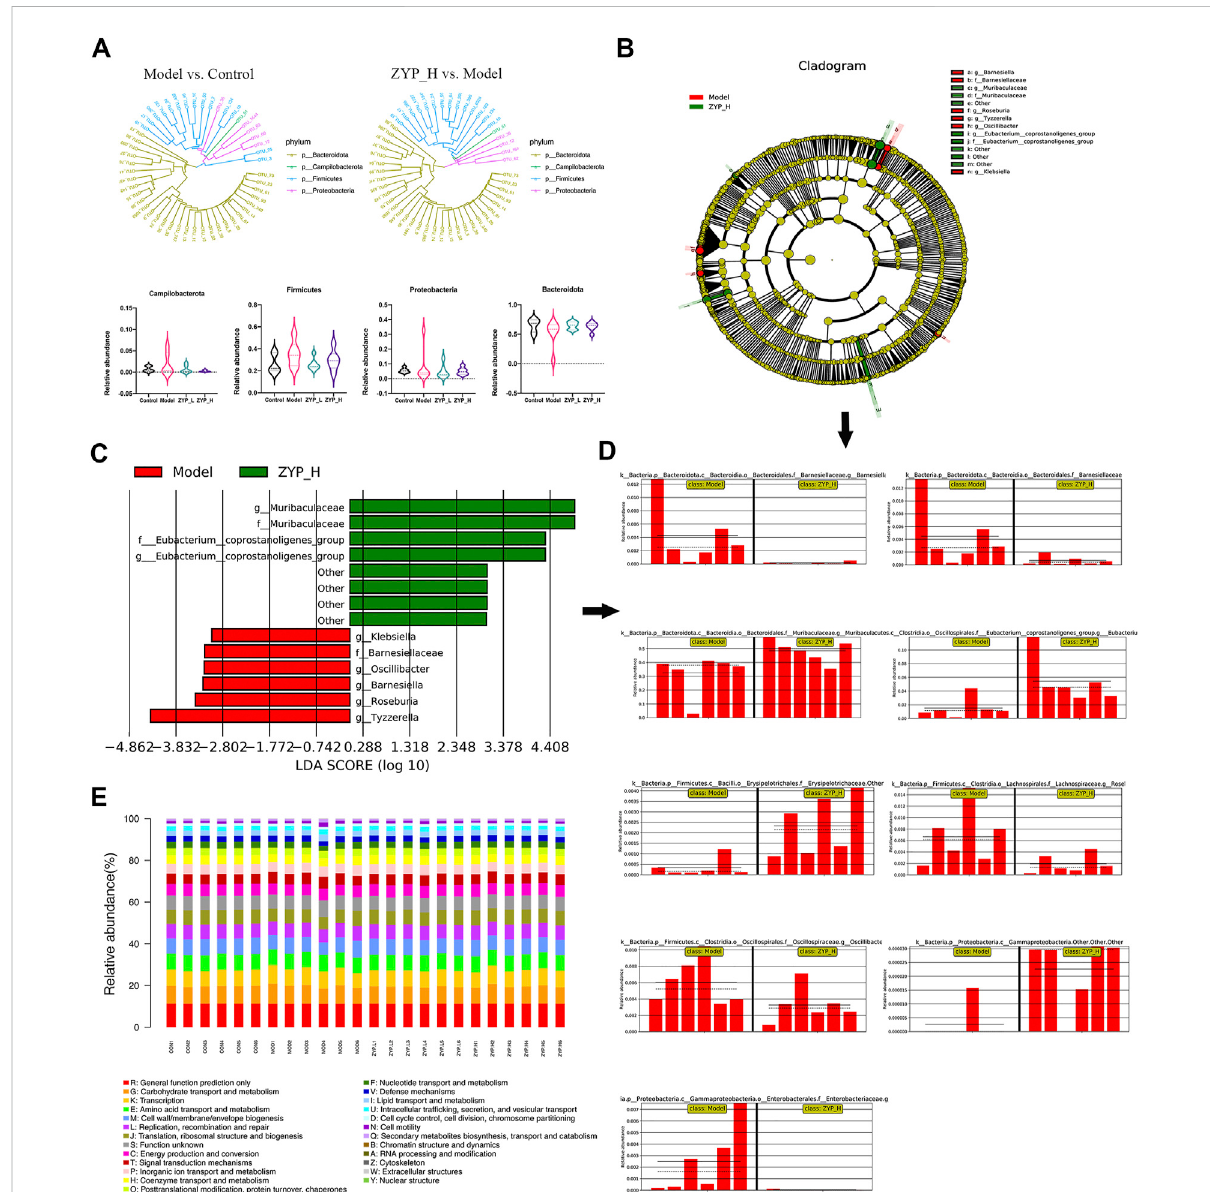
FIGURE 5 Multivariate statistical analysis of microbial data. (A) Phylogenetic analysis and histogram of relative abundance of top 50 OTUs. The phylogenetic tree was reconstructed using the maximum-likelihood method; (B) Evolutionary clade of LEfSe analysis, taxonomic representation of statisticallyandbiologicallyconsistentdifferencesbetweenmodelandZYP_Hgroups.Differencesarerepresentedinthecolorofthemostabundant class(redindicatingmodelgroups,greenindicatingZYP_Hgroups); (C) HistogramofLDAvaluedistribution(redindicatingmodelgroups,green indicating ZYP_H groups); (D) Relative abundance plots of representative microbiome; (E) Bar plot of COG